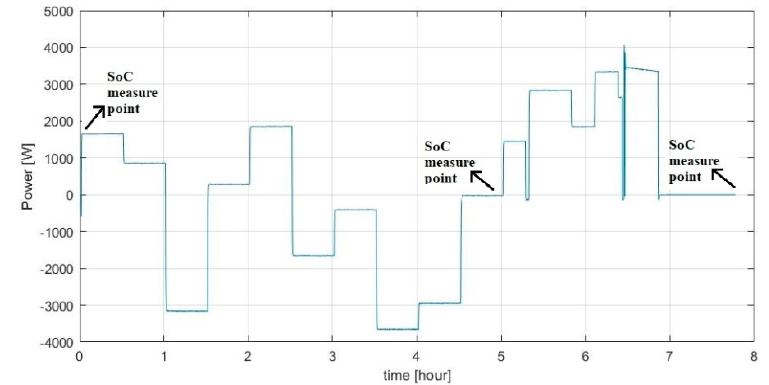
Figure 23. Test for algorithm evaluation.